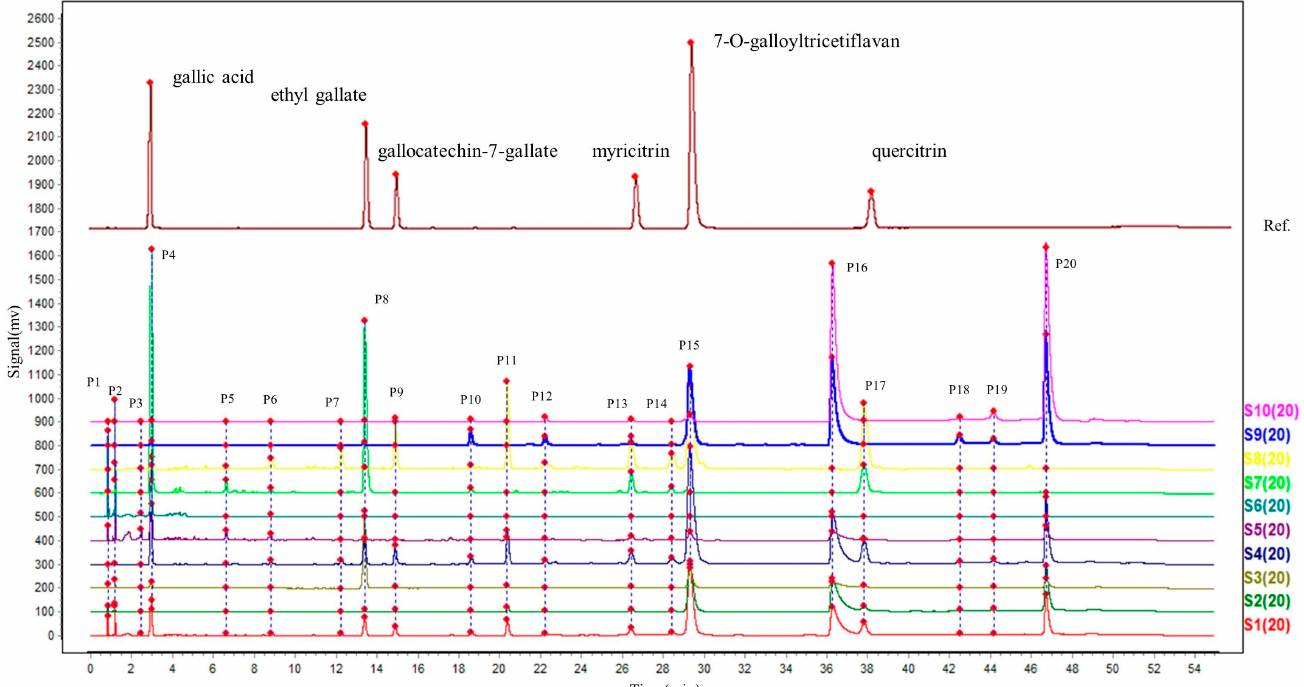
Figure 3. UPLC chromatograms of the different polarity extracts of A. clypearia and standard solu-